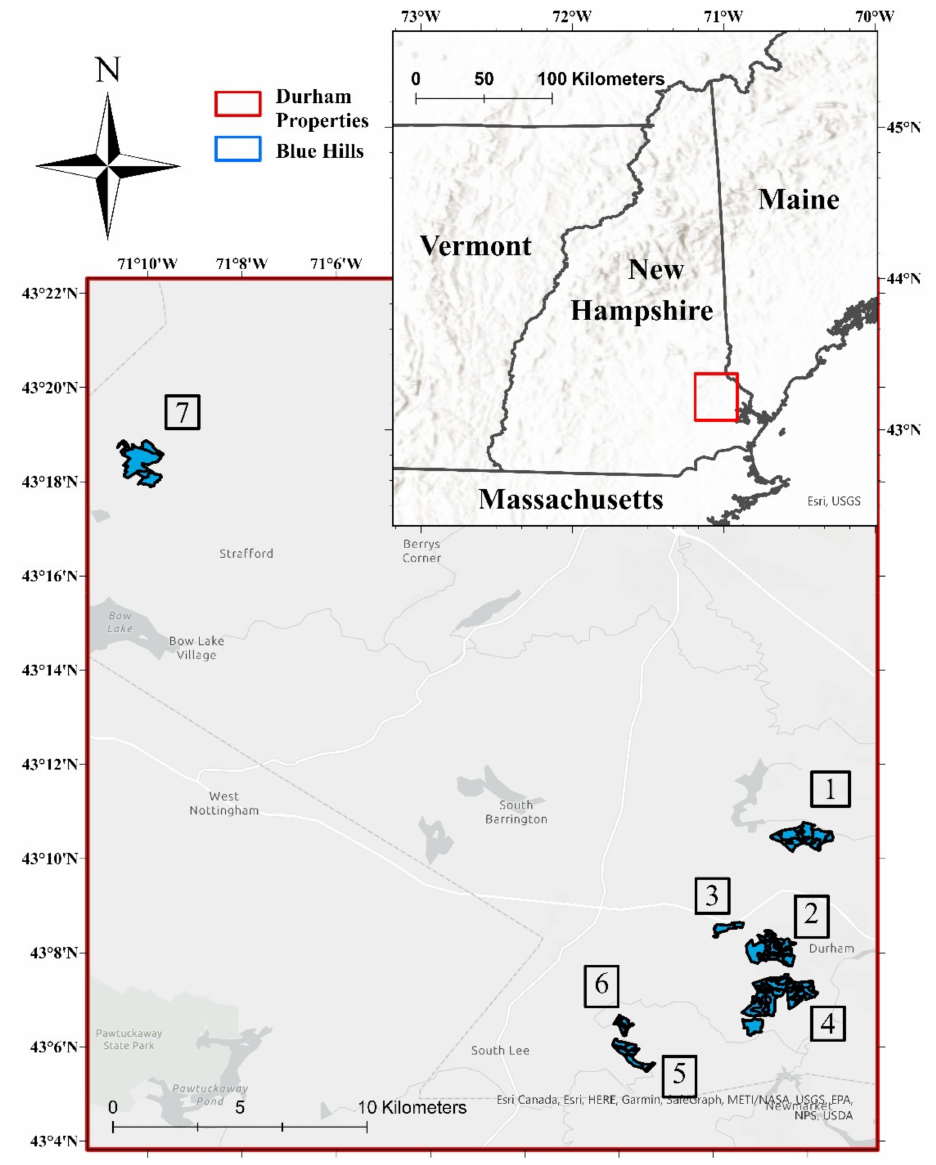
Figure 1. Depiction of the forest stands for each of the seven study areas located in southeastern New Hampshire. In numbered order: (1) Kingman Farm (97.2 ha), (2) College Woods (111.6 ha), (3) Moore Fields (17.2 ha), (4) East Foss Farm (59.9 ha), (5) Burley-Demeritt (43.9 ha), (6) Dudley (17.5 ha), and (7) Blue Hills (118.6